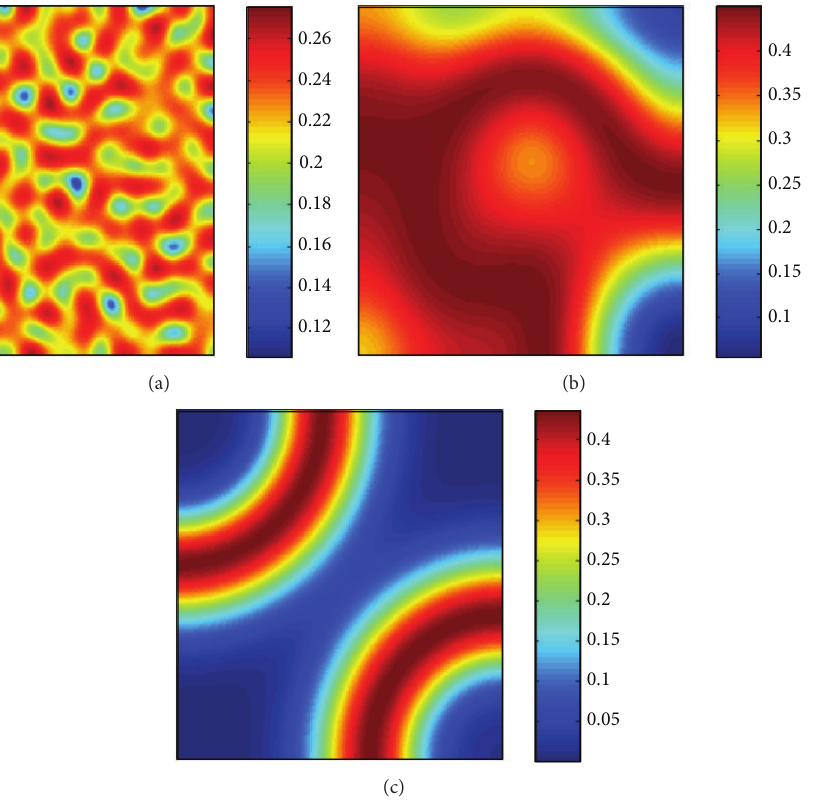
Figure 11: Snapshots of contour pictures of the time evolution of predator in system (3) when 𝑑 2 = 7 and 𝛿 = 0.2 < 𝛿 𝑤 : (a) 5000 iterations, (b) 30000 iterations, and (c) 261000